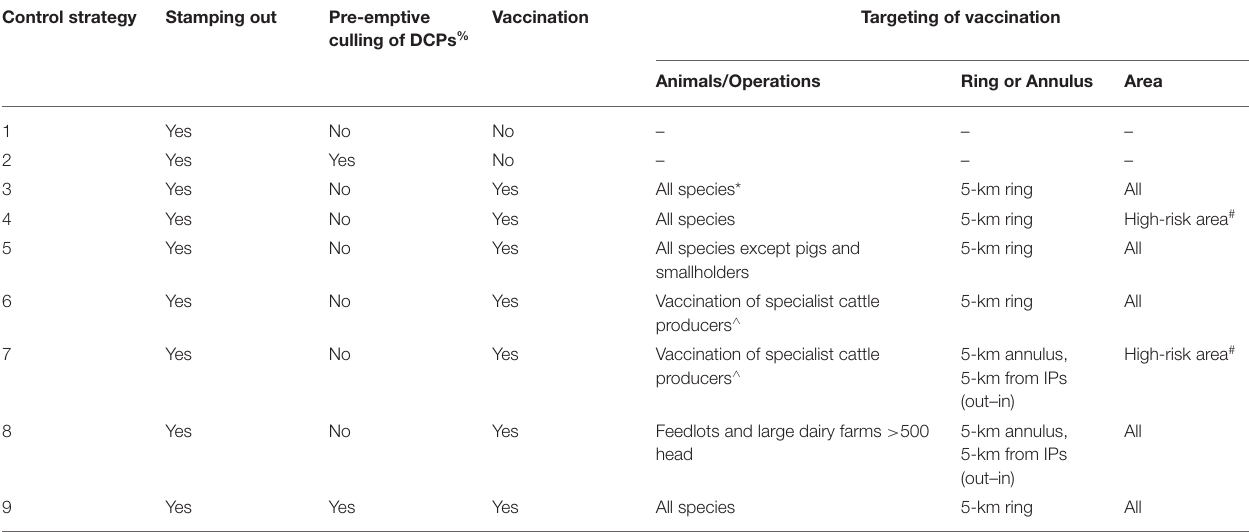
TABLE 3 | Description of each control strategy in terms of approach to stamping out and targeting of vaccination. Control strategy